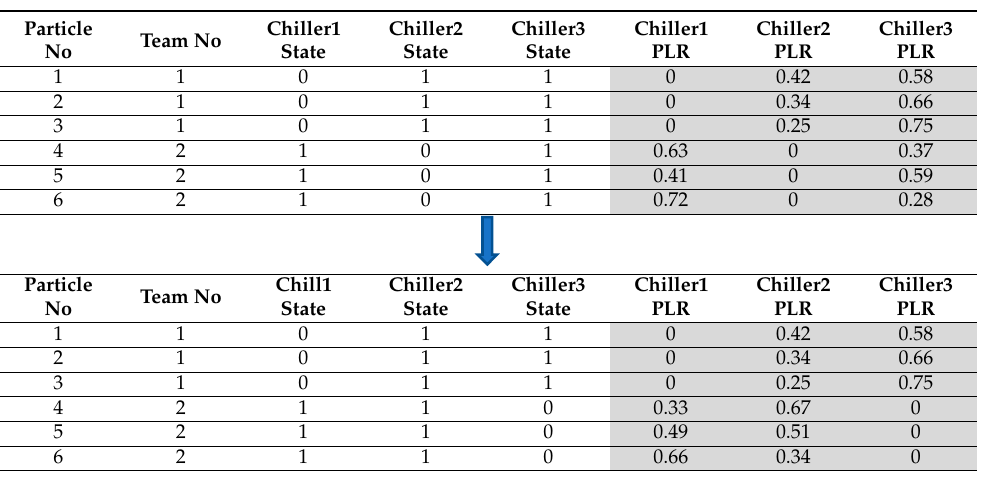
Table 6. Coefficients of power curve of chillers in 3